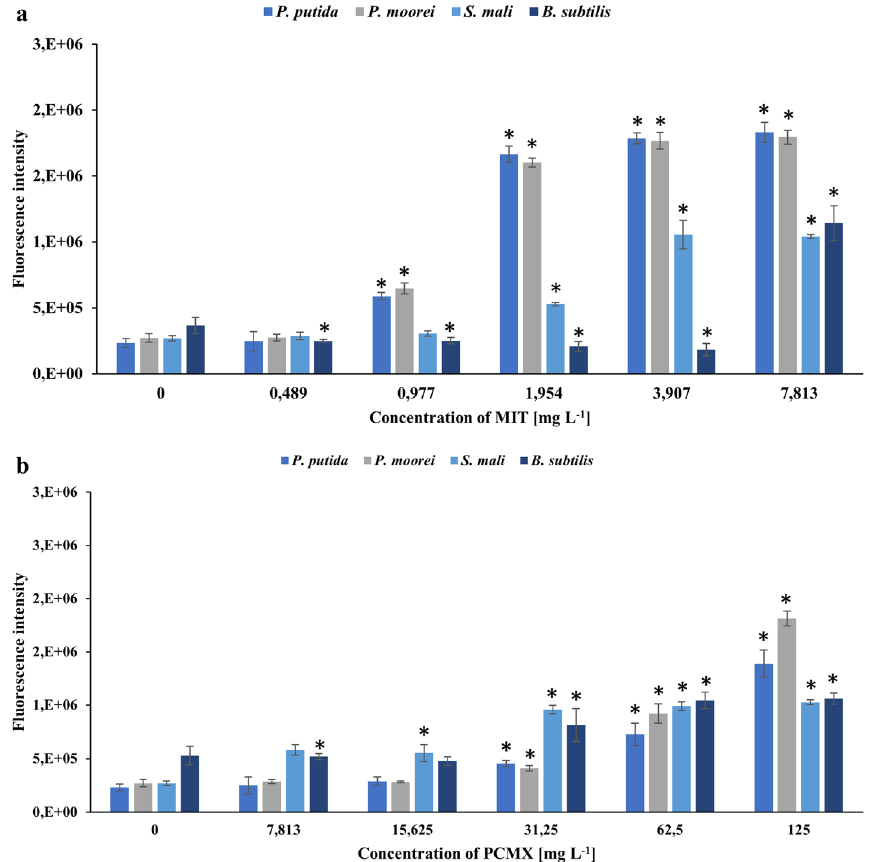
Figure 5. The effect of MIT ( a ) or PCMX ( b ) on the membrane permeabilization of the tested bacteria. Data are expressed as the average fluorescence intensity ± SD (n = 3). The presented results were analysed using the Mann ‒ Whitney U test with *p < 0.05.